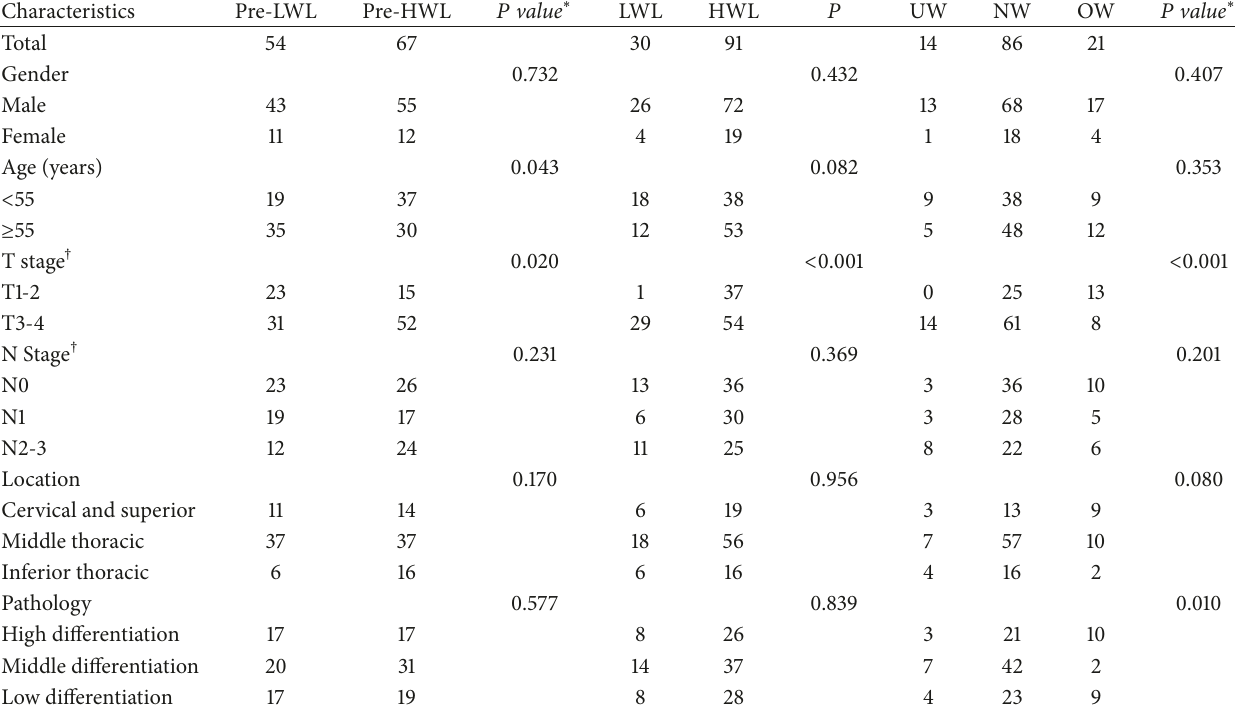
Table 1: Characteristics of the 121 patients with esophageal carcinoma enrolled in this